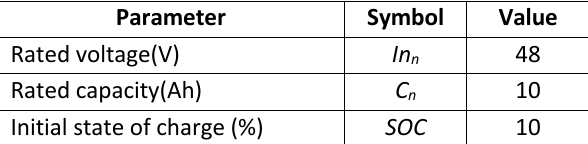
Table 3: Specifications of the battery used